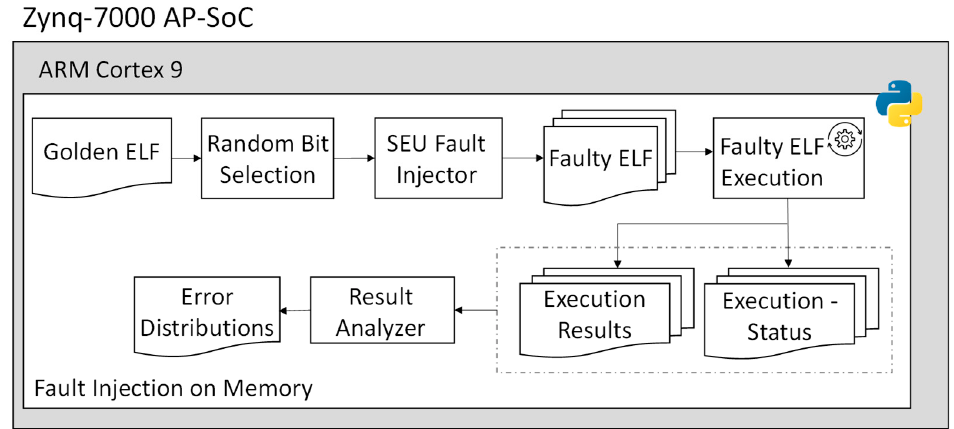
Figure 4. The Developed environment for SEE injection on memory.